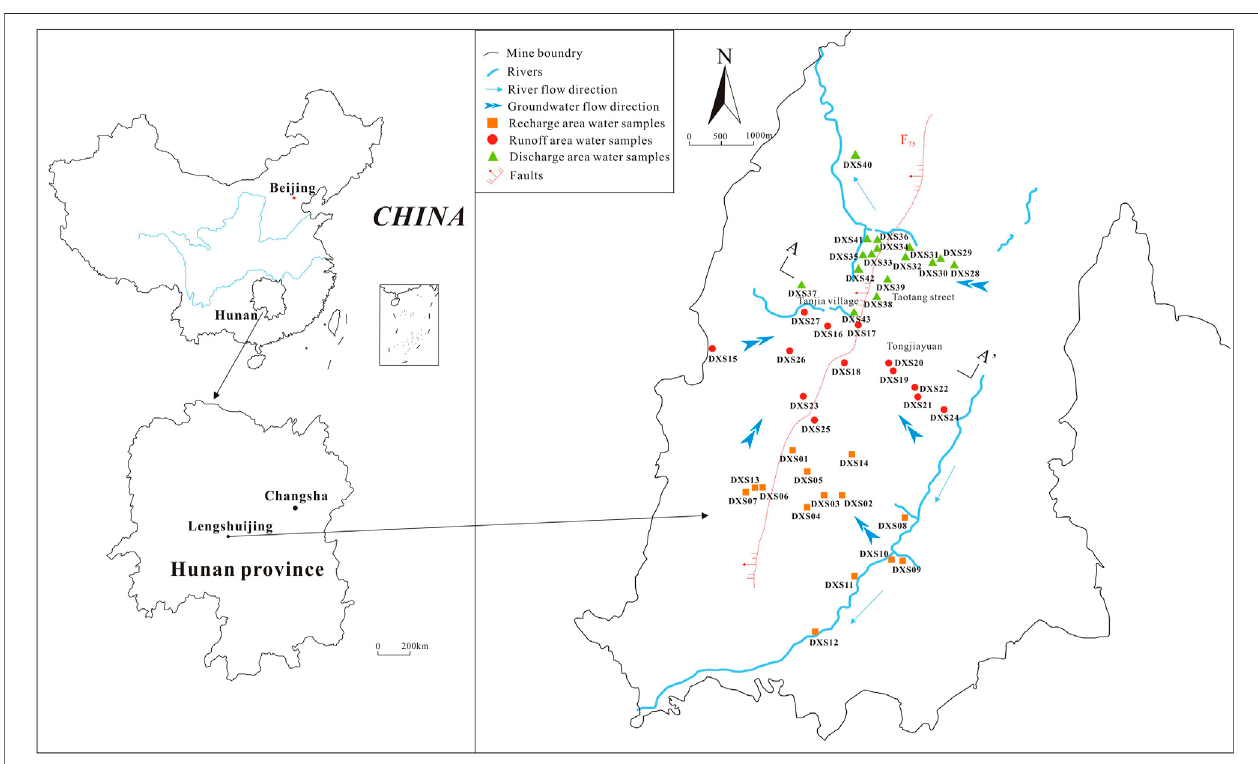
FIGURE 1 | Study area in the Hunan Province and sampling locations.